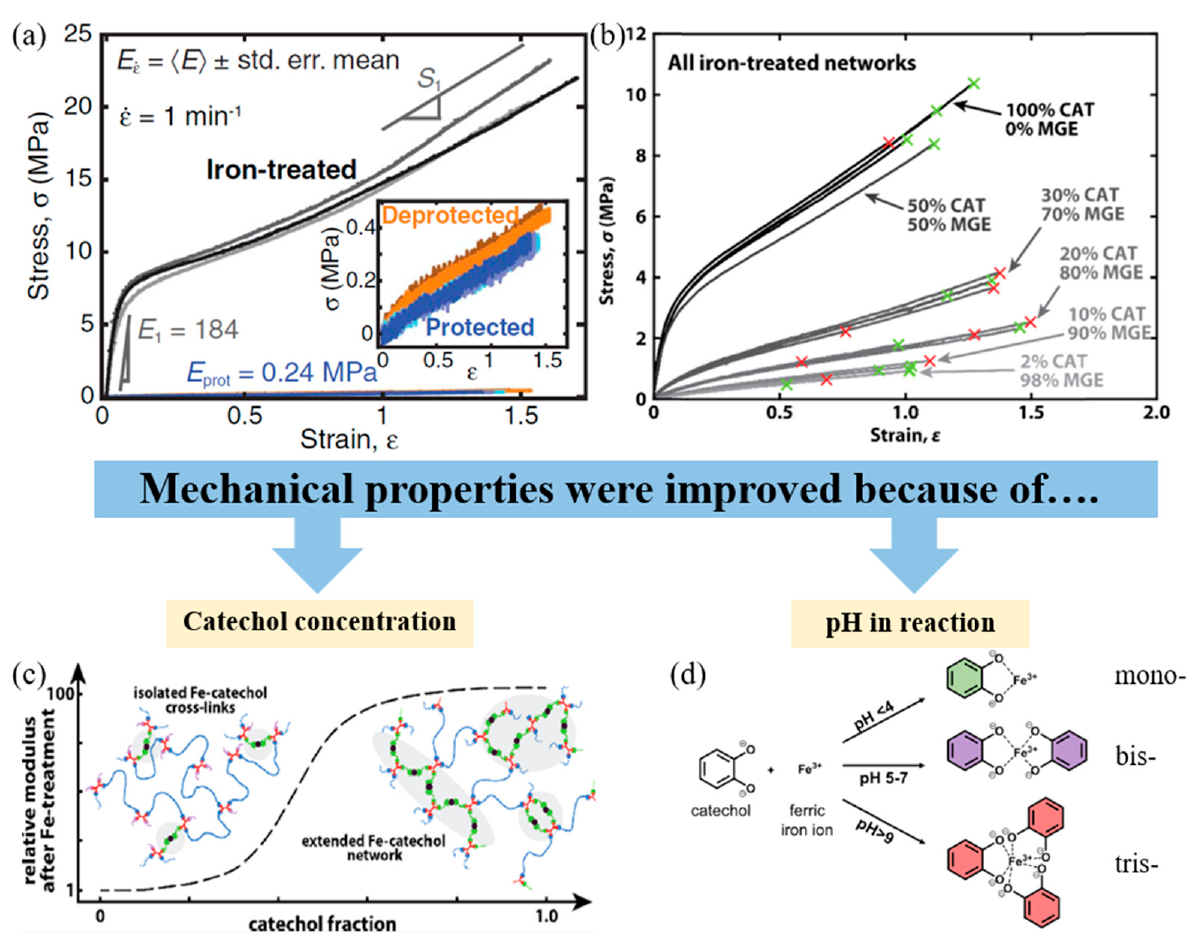
Figure 7. Metal–ligand interaction improves the mechanical properties of coordination complexes depending on the catechol content and pH of the system [85,86,88]. Adapted ( a ) from [85], with permission from AAAS; Adapted ( b , c ) with permission from [86]. Copyright 2020 American Chemical Society; Adapted ( d ) from [88], with permission from Springer Nature.